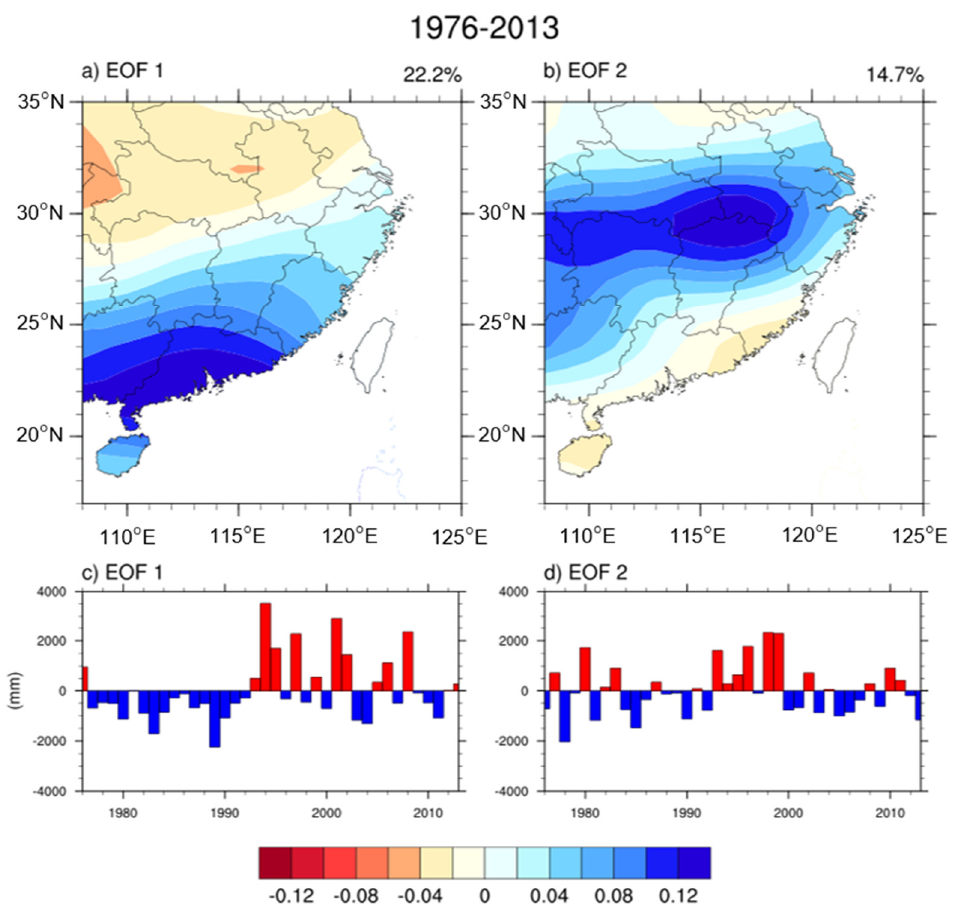
Figure 7. Leading EOF patterns ( a ) EOF1 and ( b ) EOF2 of summer rainfall and corresponding time coefficients ( c ), ( d ) during 1976–2013.